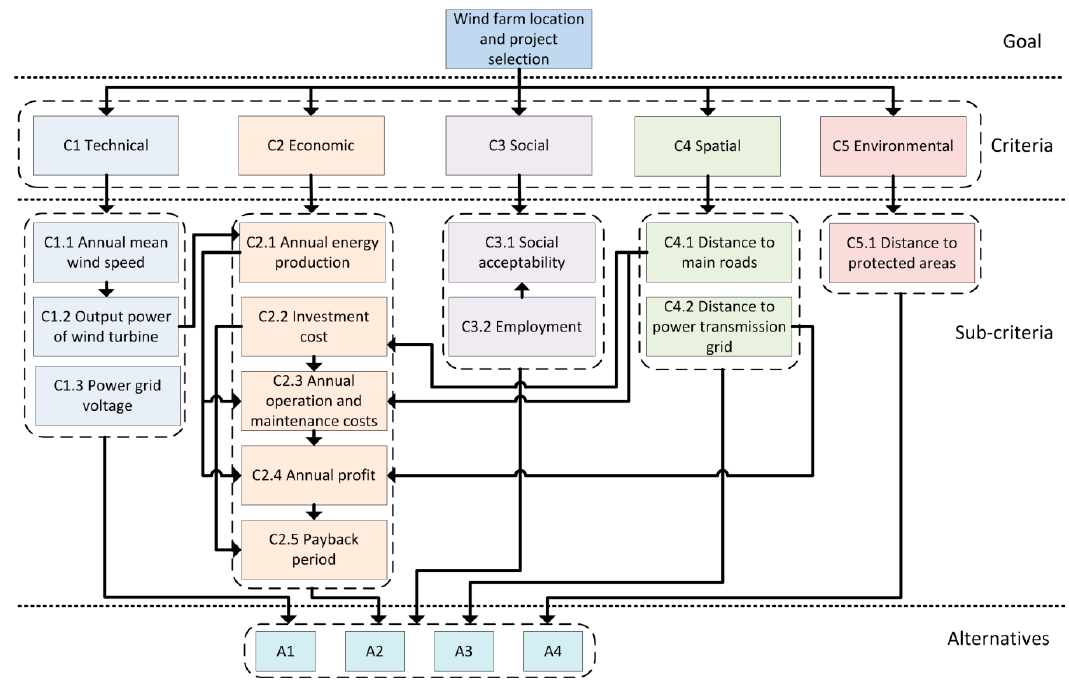
Figure 3. Decision model with alternatives and dependencies between sub-criteria